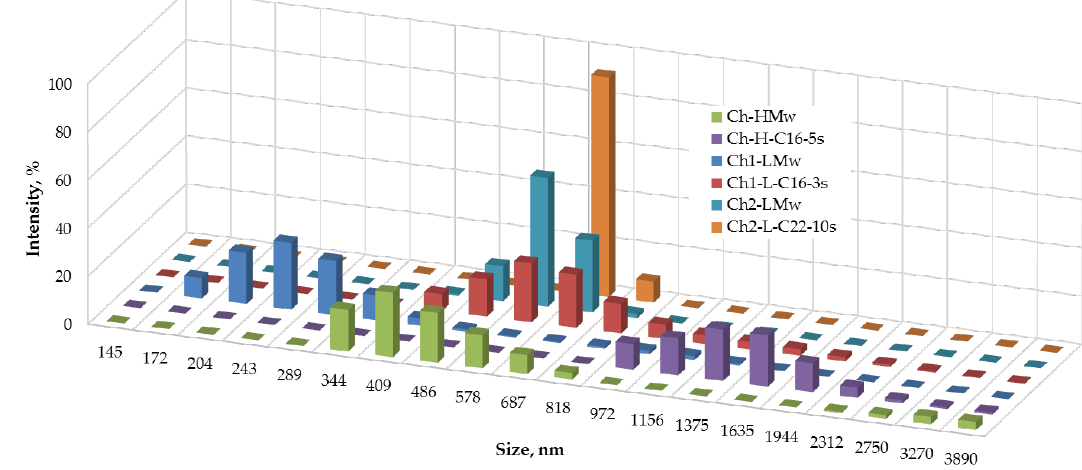
Figure 6. Number-weighted size distribution of macromolecular associates of native chitosan samples (Ch1-LMw, Ch2-LMw and Ch-HMw) and their N -alkyl derivatives in 0.2 wt-% solutions in aqueous acetic acid.